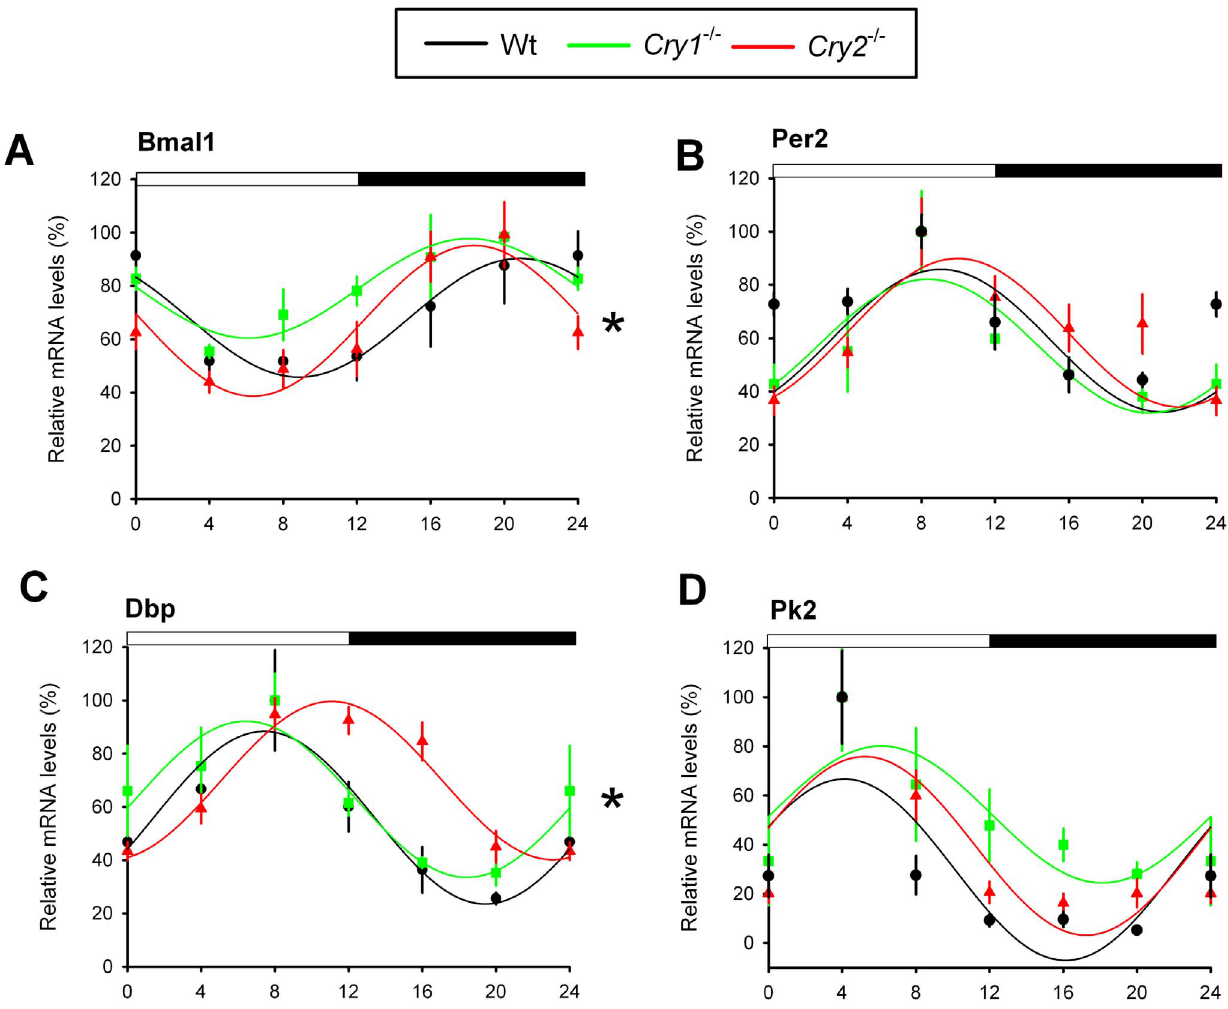
Figure 2. Circadian gene expression in the SCN of Cry1 -/- and Cry2 -/- mice. Relative mRNA expression profiles of core clock genes Bmal1 (A) and Per2 (B) and the clock-controlled genes Dbp (C) and Pk2 (D) in the SCN of light entrained (LD) wild type (black), Cry1 -/- (green) and Cry2 -/- (red) mice, as measured by RT-qPCR. For each genotype, mRNA levels (mean 6 s.e.m) are expressed relative to the peak of expression (set at 100%) and fitted with a wave curve. The two-way ANOVA test revealed a significant effect of genotype and time interaction (*p , 0.05). Data at ZT0 and ZT24 are double-plotted for easier visualization of daily expression. The bar above panels indicates time of light on and off.